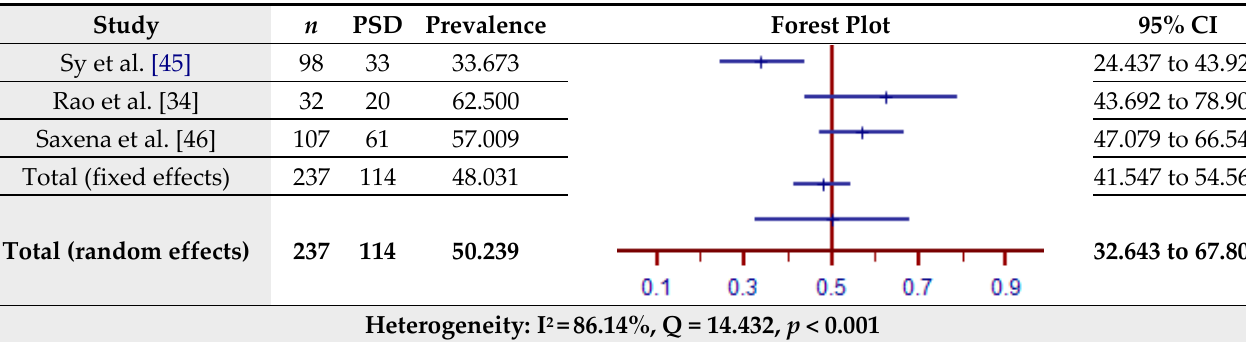
Figure 7. Prevalence estimates of Post-Stroke Depression (PSD) assessed by the Geriatric Depression Scale (GDS15/30).